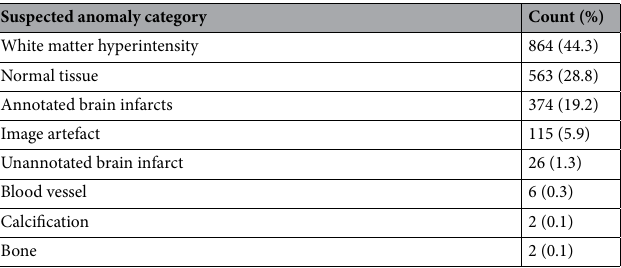
infarcts represented 97.5% of the total brain infarct volume. Eight hundred and sixty-five (44.3%) suspected anomalies were caused by white matter hyperintensities. Image artefacts, e.g. due to patient motion, attributed